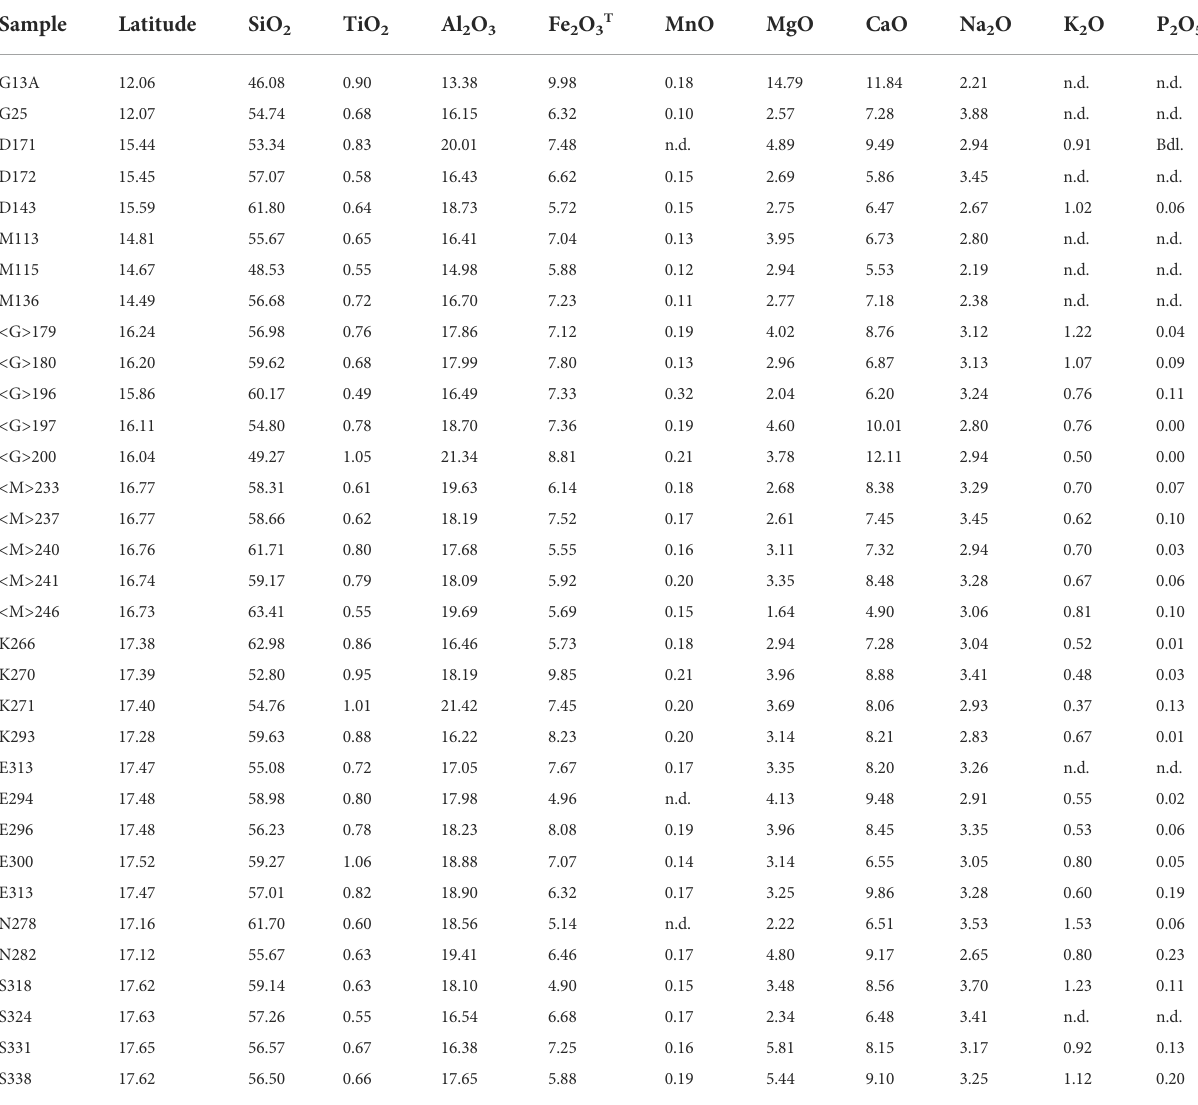
TABLE 1 Major element abundances of selected samples from the LAIA. Major elements were measured either on an ARL DCP-OES or a Perkin Elmer Avio 200 ICP-OES after digestion by LiBO 2 fl ux fusion. n.d.-no data obtained, bdl. — data was below detection limit for this methodology (G, Grenada, D, Dominica, M, Martinique, < G > , Guadeloupe, < M > , Montserrat, K, St. Kitts, E, St. Eustatius, N, Nevis, S,